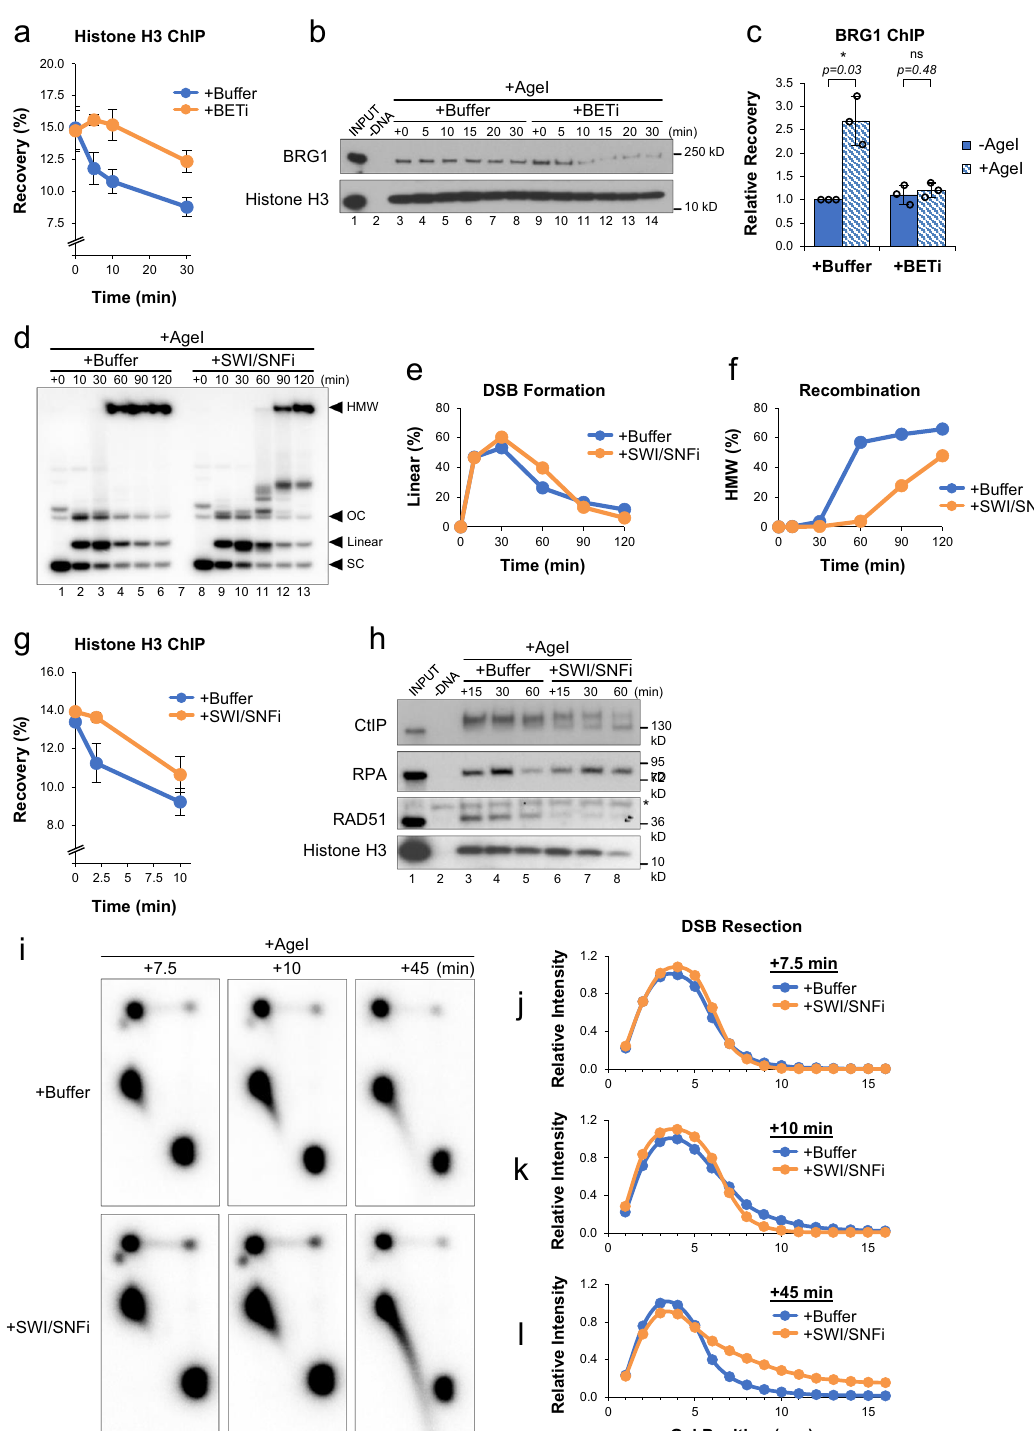
protein. Pro fi les of protein and mRNA levels during Xenopus development indicate that eggs are highly enriched for BRD4 compared to BRD2 and BRD3 63 – 65 . Although BRD2 and BRD3 antibodies supported little or no immunoprecipitation (Supple- mentary Fig. 8a, b), BRD4 antibodies readily depleted BRD4 without co-depletion of BRD2 or BRD3 (Fig. 4a), allowing us to investigate BRD4 ’ s speci fi c contribution to DSB repair. We found that depletion of BRD4 led to similar defects in repair as BET inhibition. In the absence of BRD4, resolution of linear molecules